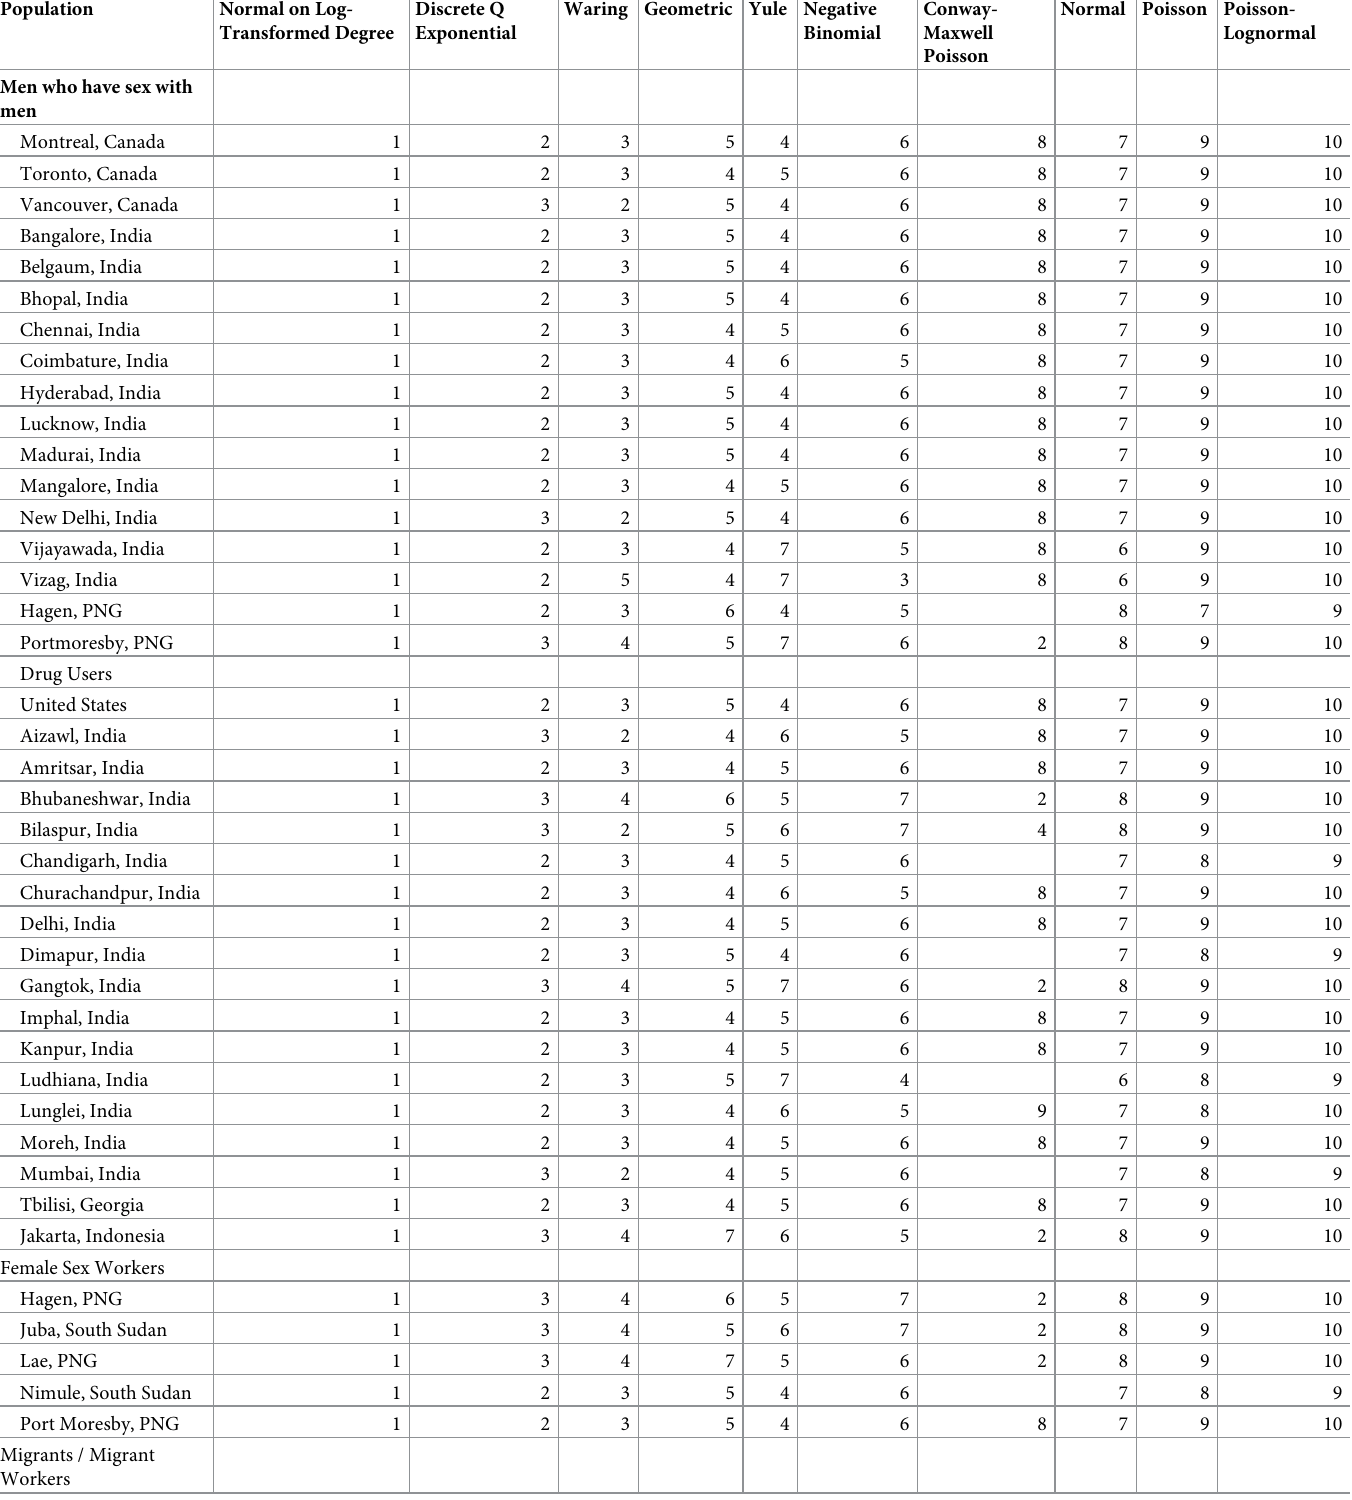
Discrete Q Waring Geometric Yule Negative Exponential